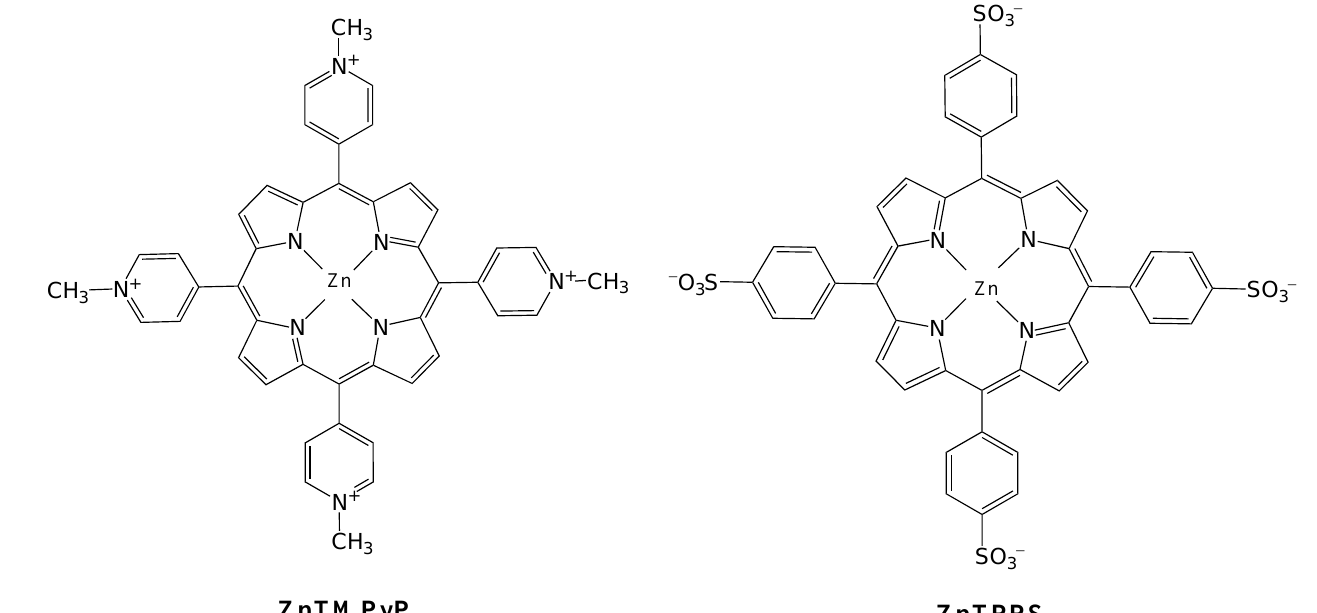
Figure 1. Structures of zinc(II) meso-tetrakis methylpyridiniumyl (Zn 2 + TMPyP) and zinc(II) meso-